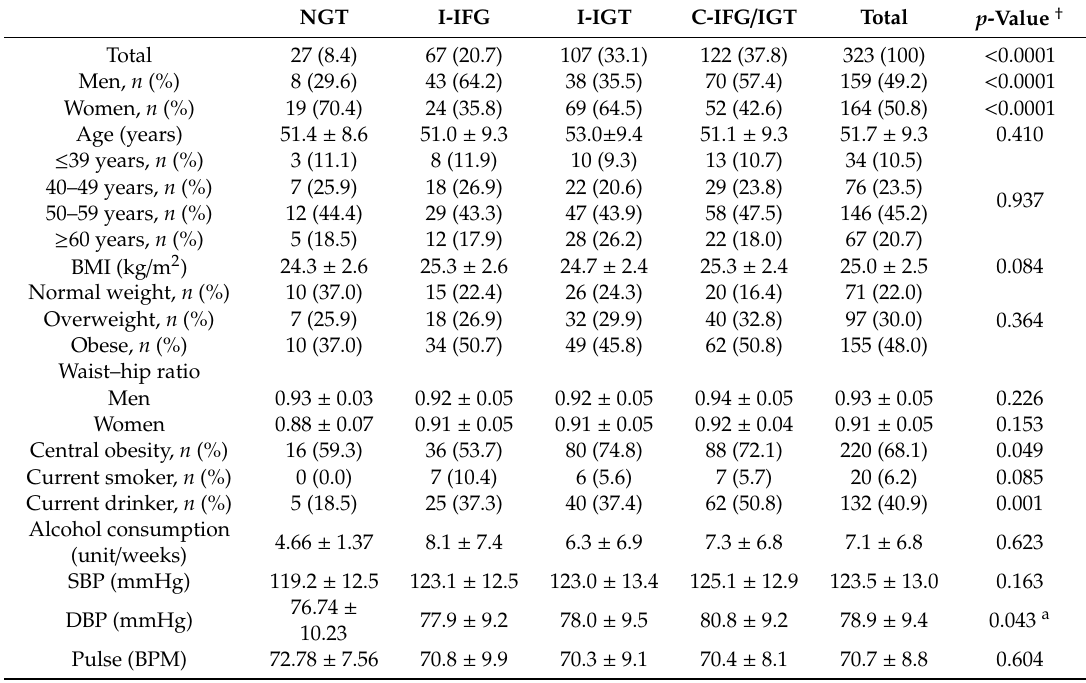
Table 1. General characteristics of the subjects according to prediabetes subtypes.